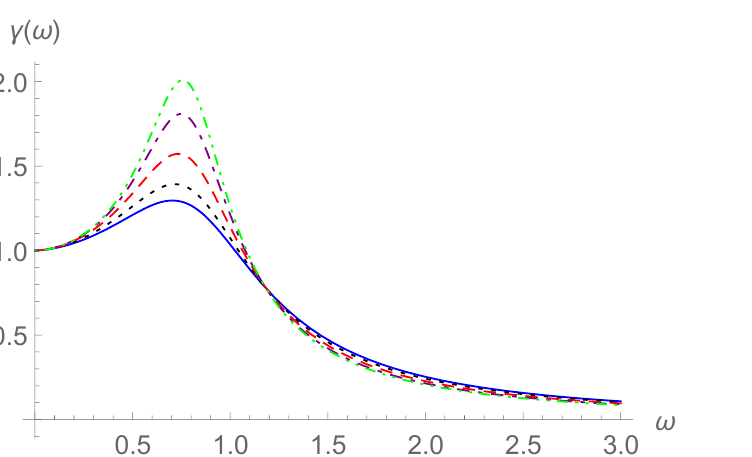
Figure 11. Frequency–amplitude curves γ ( ω ) for k = m = 1, c = 0.5, η = 0.5, and p = 0.01 (solid line), p = 0.1 (dotted line), p = 1 (dashed line), p = 10 (dot-dashed line), or p = 100 (dot-dot-dashed line).